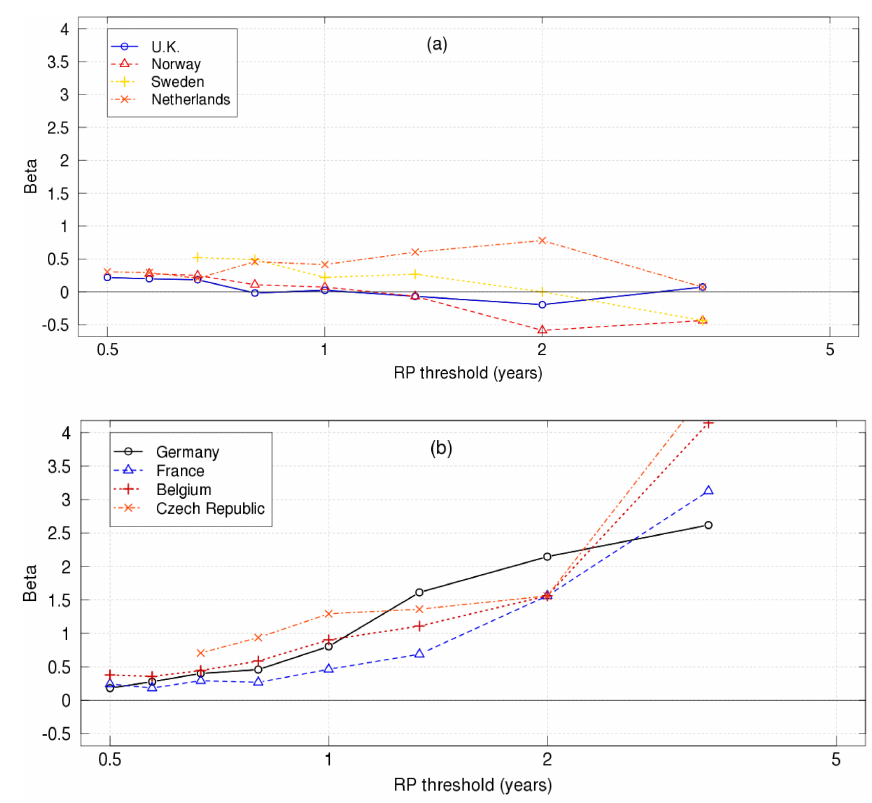
Figure 7. As Fig. 6, for various countries in (a) northern part and (b) southern part of the study area.